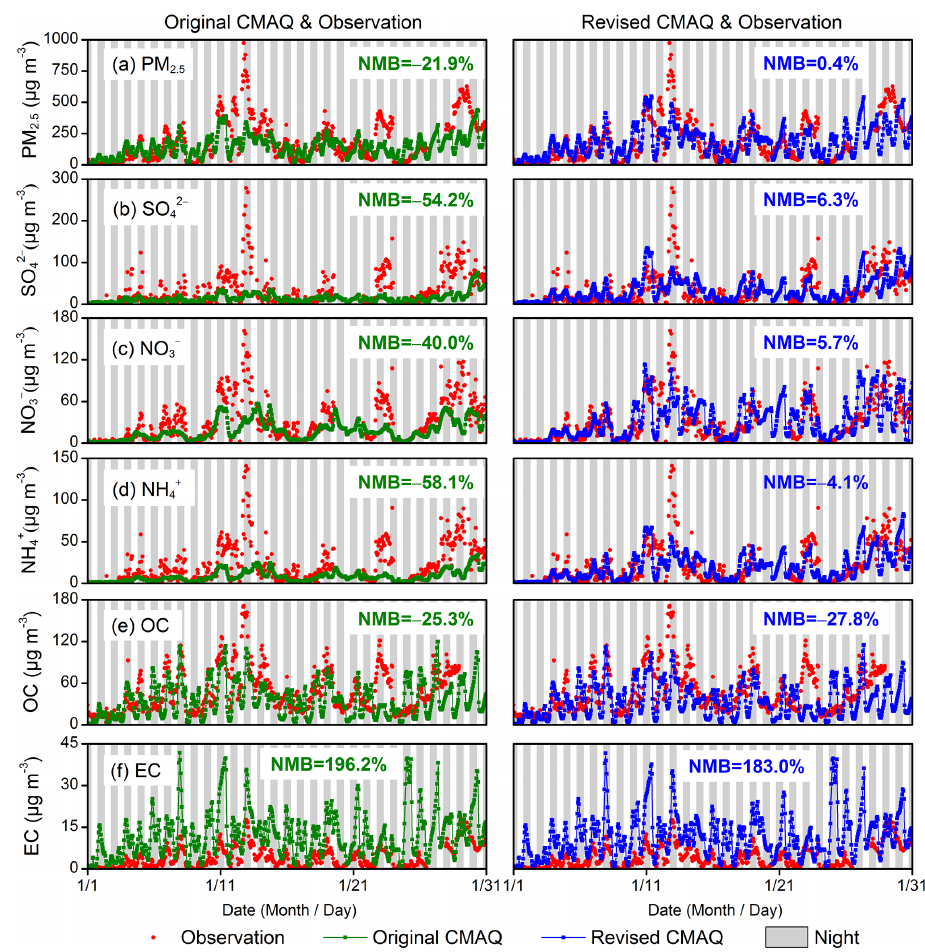
Figure 4. Observed and simulated hourly aerosol compositions from the original and revised CMAQ at the THU site: (a) PM 2 . 5 ; (b) SO 2 − (c) NO − ; (d) NH + ; (e) OC; (f) 3 4